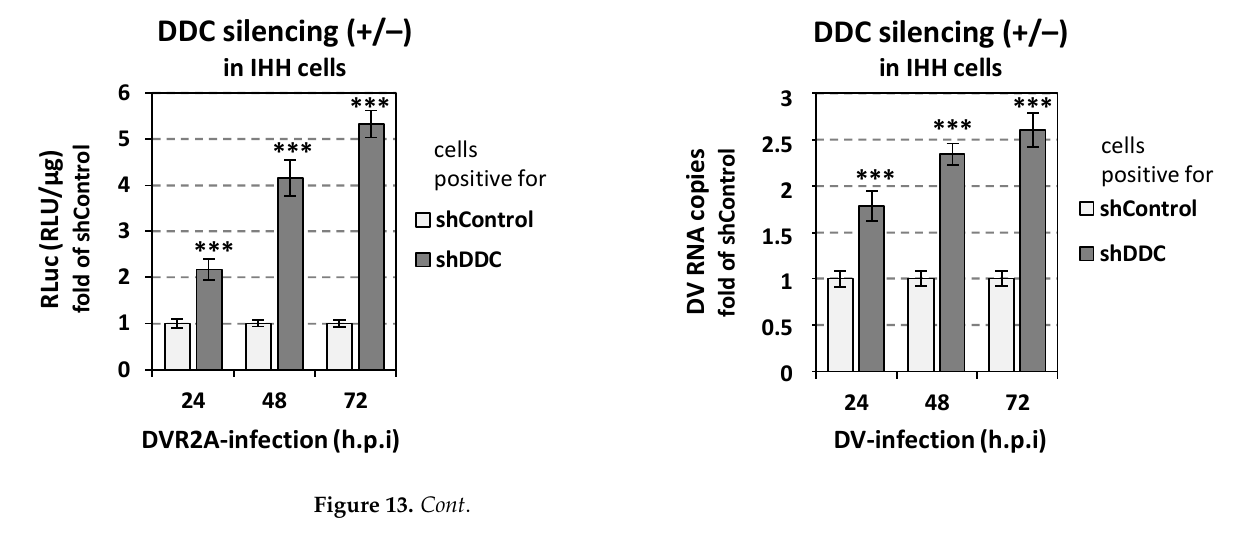
Figure 13. The activity of the catecholamine biosynthesis/metabolism pathway negatively regulates DV replication in immortalized human hepatic (IHH) and blood monocytic (THP-1) cell lines. ( A )